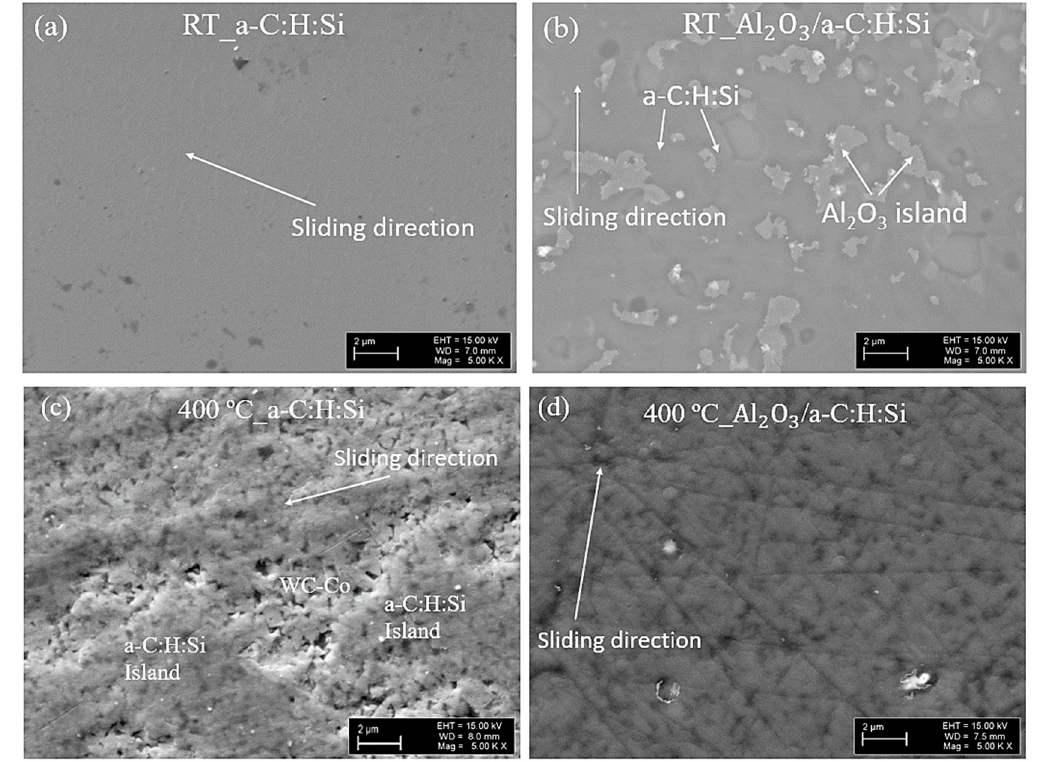
Figure 3. SEM images of wear scars after sliding tests at ( a , b ) RT for 180 min and ( c , d ) 400 ◦ C for 5